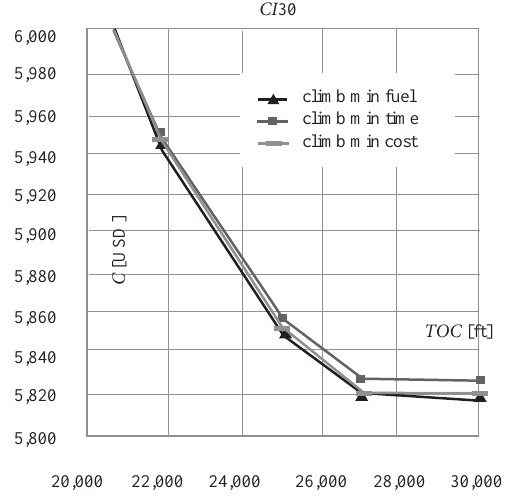
Fig. 10. Comparison of en route flight total costs for three types of climb techniques, CI =